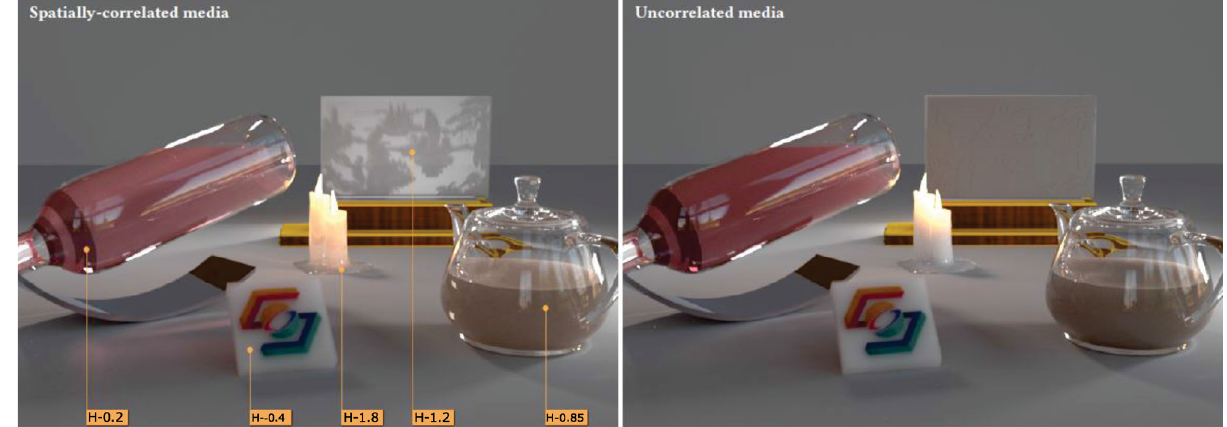
Fig. 23 Left: a complex scene containing several spatially-correlated media: the fractional Gaussian field (FGF) is able to reproduce a wide range of appearances stemming from short-range to long-range correlations and supports macroscopic heterogeneity. Right: reference generated by classical transport theory for comparison. Reproduced with permission from Ref. [74], c (cid:2) ACM